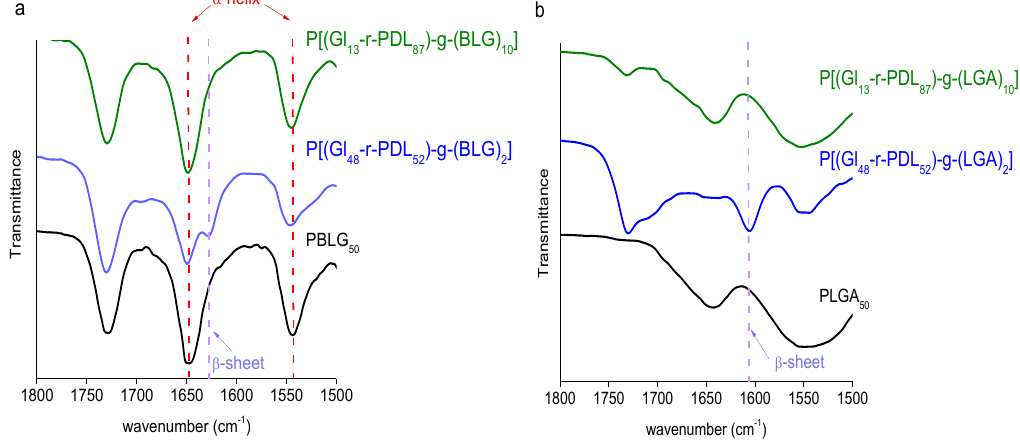
Figure 5. FTIR spectra of P[(Gl x - r -PDL y )– g –(LGlu) z ] copolymers and reference polypeptides poly( γ -benzyl L-glutamate) (PBLG) and poly(L-glutamic acid) (PLGA). X-ray diffraction (XRD) of the hybrid copolymers in the solid state afforded complementary information in support of the results obtained by both DSC and FTIR. XRD profiles of the P[(Gl 13 - r -PDL 87 ) – g – (BLG) 10 ] copolymer recorded at real time at temperatures varying over the 0 – 200 °C range are shown in Figure 6. The 0.41 and 0.37 nm peaks present in the low temperature profiles P(Gl x - r -PDL y ) copolyesters. According to DSC results, these peaks disappeared at temperatures